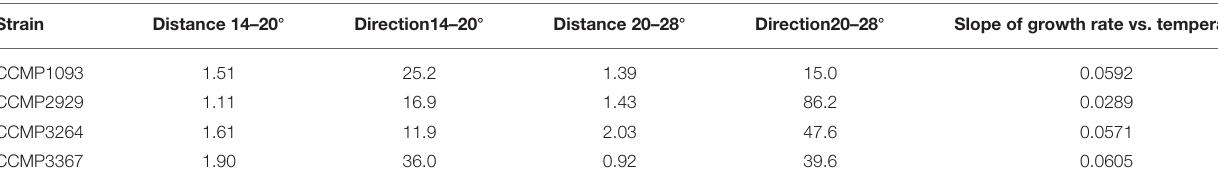
TABLE 3 | Distance and direction (degrees from the horizontal) between phenotype centroids for strains grown at 14, 20, and 28 ◦ C in f/2 media at 200 µ mol m − 2 s − 1 of light on a 12:12 light cycle. Strain Distance 14–20 ◦ Direction14–20 ◦ Distance 20–28 ◦ Direction20–28 ◦ Slope of growth rate vs. temperature CCMP1093 1.51 25.2 1.39 15.0 0.0592 CCMP2929 1.11 16.9 1.43 86.2 0.0289 CCMP3264 1.61 11.9 2.03 47.6 0.0571 CCMP3367 1.90 36.0 0.92 39.6 0.0605